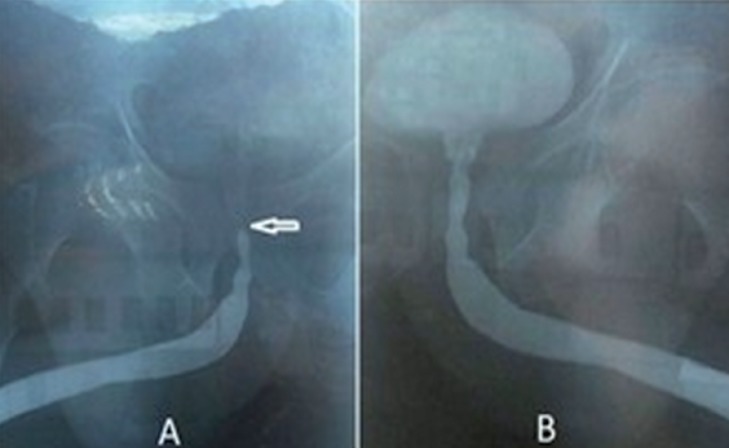
A) Preoperative RGU showing posterior urethral stricture (arrowhead). B) Postoperative RGU showing widely patent urethra after urethral dilatation.